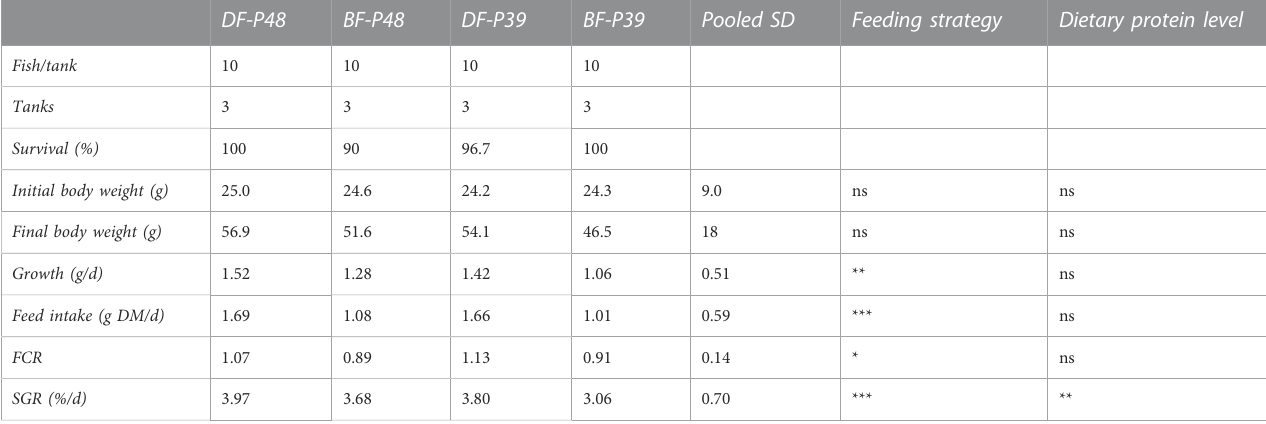
TABLE 3 Growth performances carp fed different dietary protein levels within batch-fed and demand-fed strategies in a 3-week feed experiment. DF-P48 BF-P48 DF-P39 BF-P39 Pooled SD Feeding strategy Dietary protein